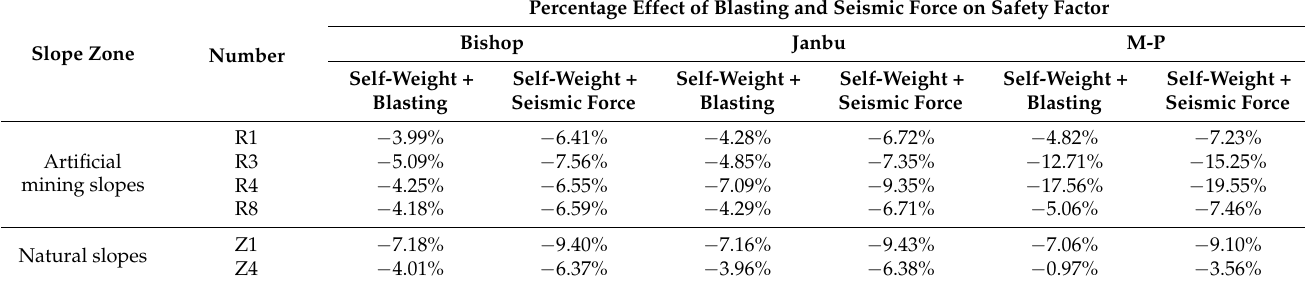
Table 10. Percentage effect of blasting and seismic force on safety